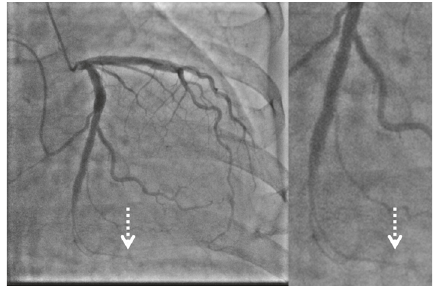
Figure 3: Emergent angiography revealed occlusion of the distal segment of the left circumflex artery (dotted arrow).